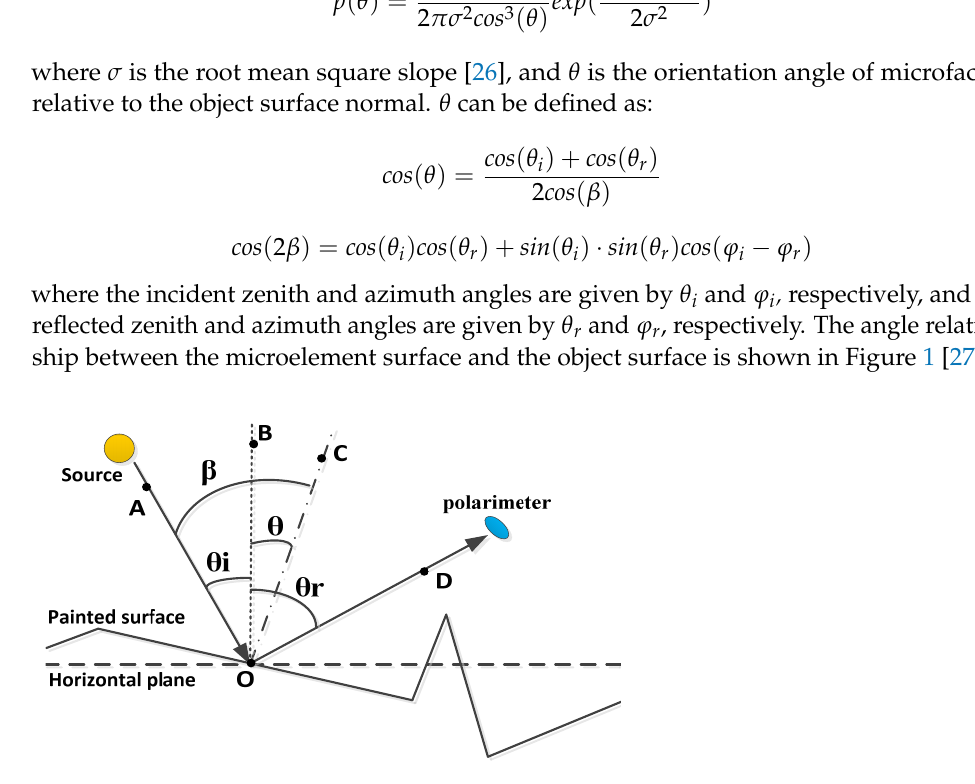
Figure 1. Angle definitions in a microfacet coordinate system; where OB is the surface normal, OC is the target microfacet normal, AO is the incident direction, and OD is the detection direction [27]. According to the physical meaning of bidirectional reflectance distribution function (BRDF), it is the ratio of the radiance L, reflected on the object surface, and the